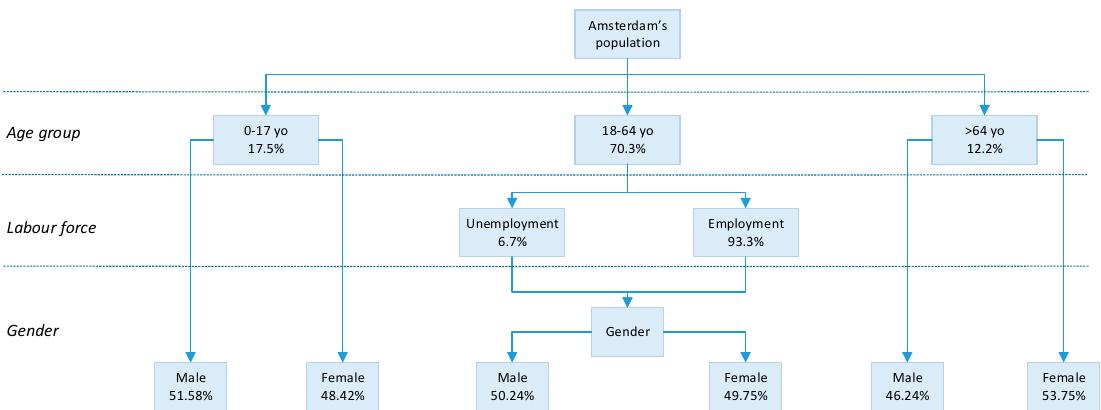
Figure 2. The application of the Weighted proportion (Wepro) model’s structure to the case-study city, namely Amsterdam, The Netherlands. It consists of the Amsterdam’s age group share, labour force composition share and gender share of each age group.